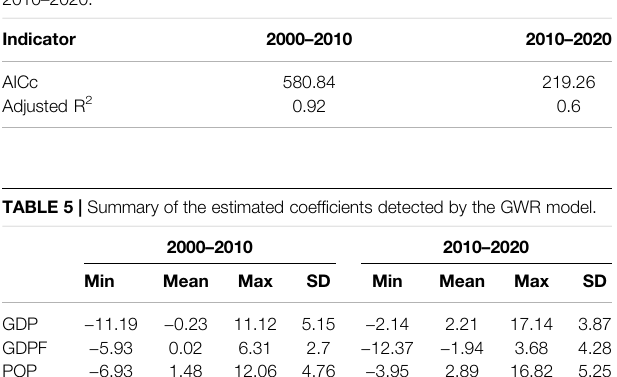
TABLE 4 | Performance of the GWR model in the periods of 2000 – 2010 and 2010 – 2020.